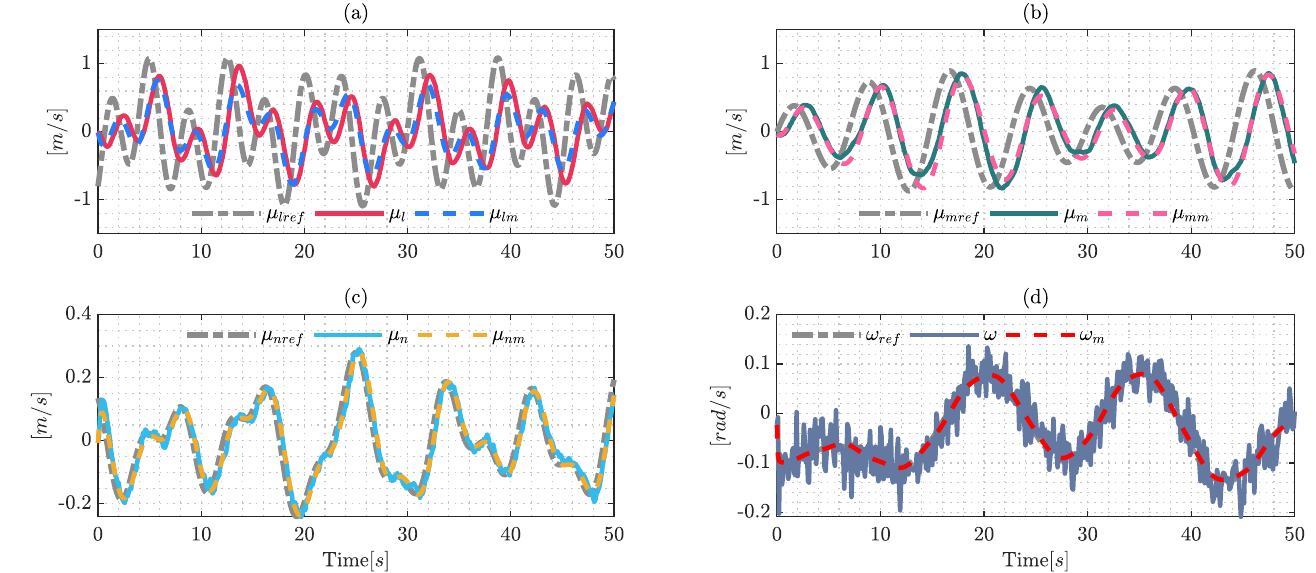
Figure 5. Validation process using dynamic mode decomposition (DMD). The results are: ( a ) vali- dation over the reference velocity µ lref ; ( b ) shows the results through velocity µ mref ; ( c ) validation over the longitudinal velocity µ nref ; and ( d ) shows the validation results of the reference angular velocity ω ref